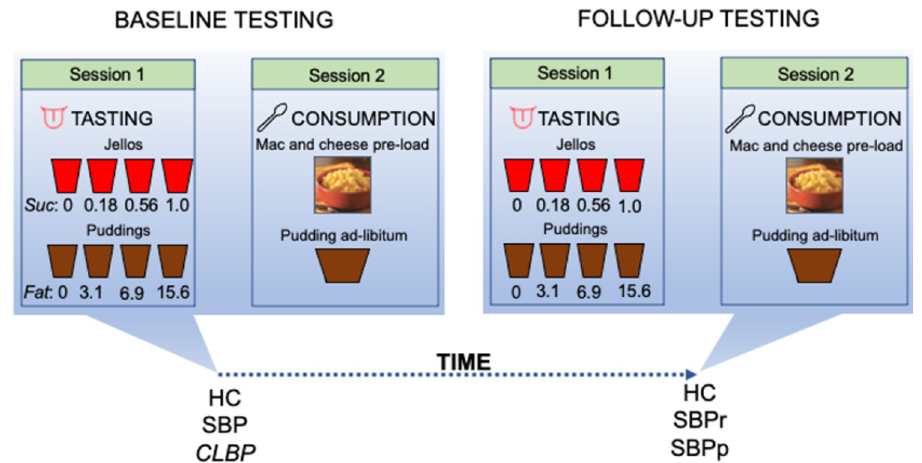
Fig 1. Schematic diagram showing the experiments performed at both time-points and during each session. Note that CLBP patients were tested once only, while SBP patients and healthy subjects were tested at two time points separated by approximately one year (i.e., baseline and